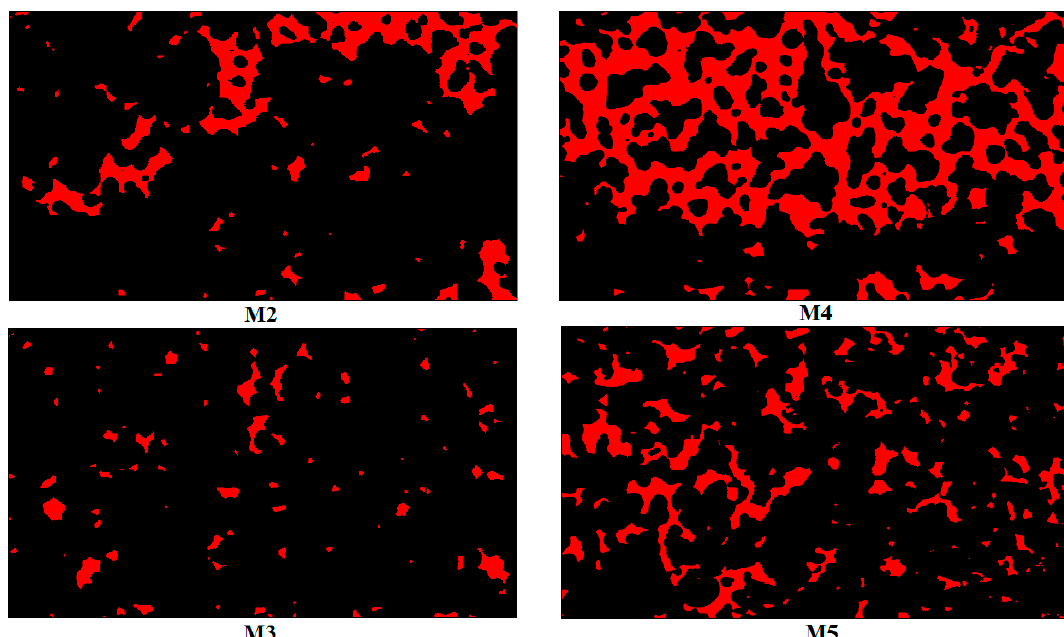
Figure 12. Illustration of the reimaging oil post flooding in CNCs experiments (M2, M4) and T-CNFs experiments (M3, M5). M4 and M5 were performed with 10 times higher injection rate, i.e., at 1.8 µL/min vs. 0.18 µL/min flow rate.